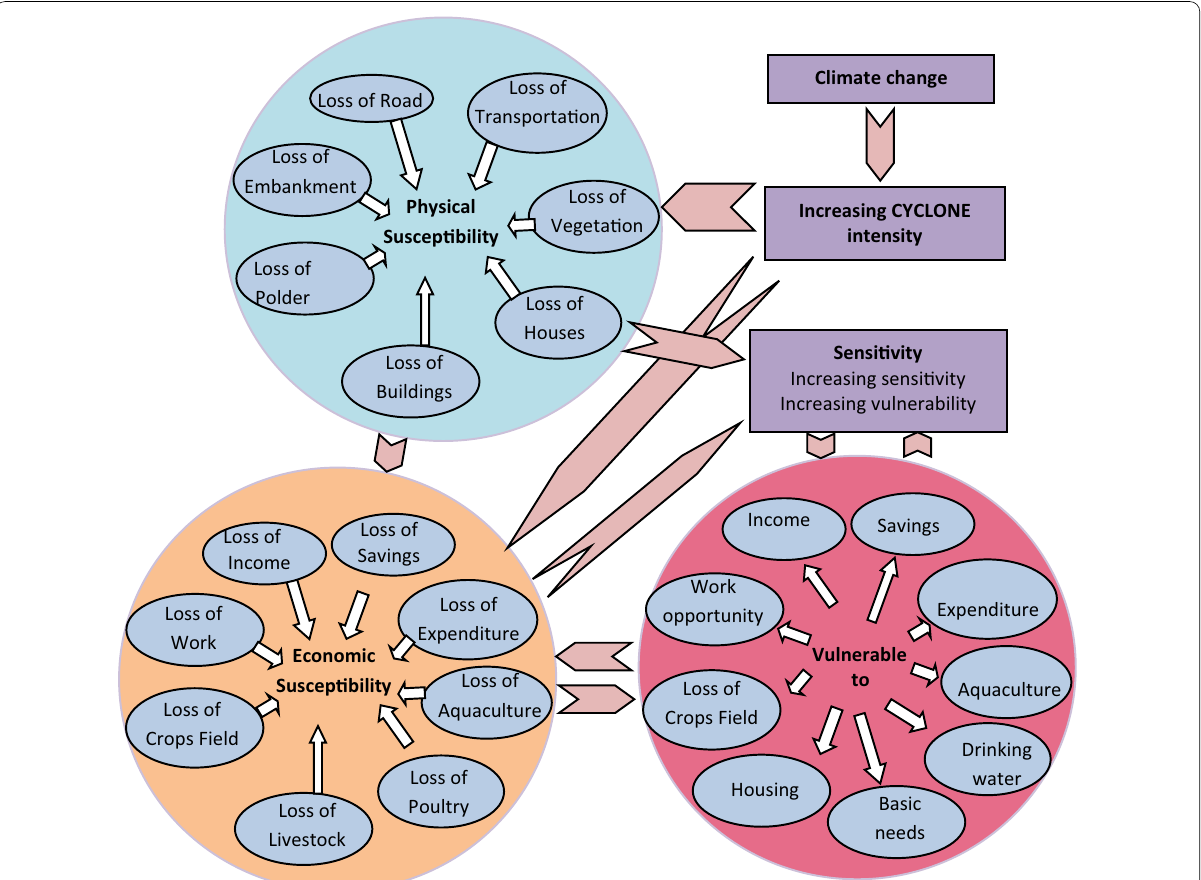
Fig. 7 Linkage among cyclone, physical and economic susceptibility, vulnerability and